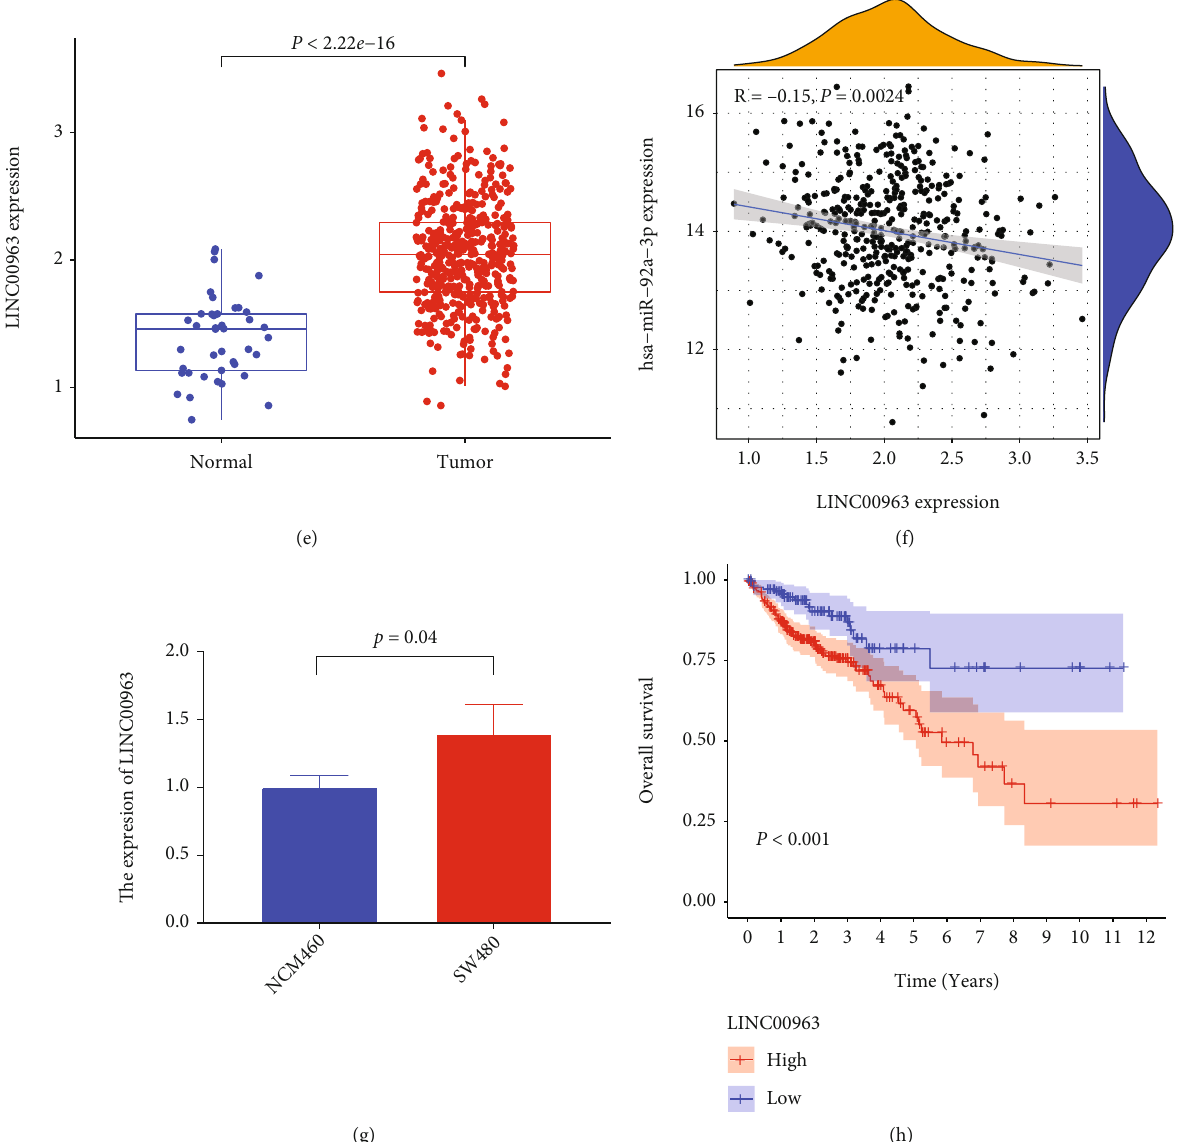
Figure 6: LY6E-related ceRNA network construction in CRC. (a) miR-92a-3p, a possible target miRNA for LY6E through the prediction of ENCORI database, is downexpressed in CRC from TCGA cohort. (b) miR-92a-3p expression was negatively correlated with LY6E expression. (c) The expression of miR-92a-3p in human normal colon epithelial cell NCM460 and human colorectal cancer cell line SW480. (d) Patients with low miR-92a-3p expression were closely correlated with poorer overall survival. (e) LINC00963, a possible target lncRNA for miR-92a-3p through the prediction of ENCORI database, is highly expressed in CRC from TCGA cohort. (f) LINC00963 expression was negatively correlated with miR-92a-3p expression. (g) The expression of LINC00963 in human normal colon epithelial cell NCM460 and human colorectal cancer cell SW480. (h) Patients with high LINC00963 expression were closely correlated with poorer overall